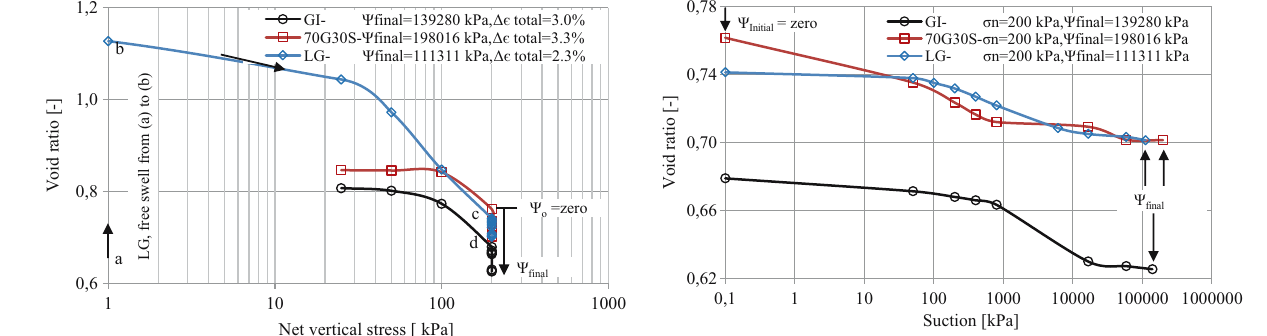
Figure 9: Variation of the void ratio with net vertical stress of the ( CN - SI ) drying test.